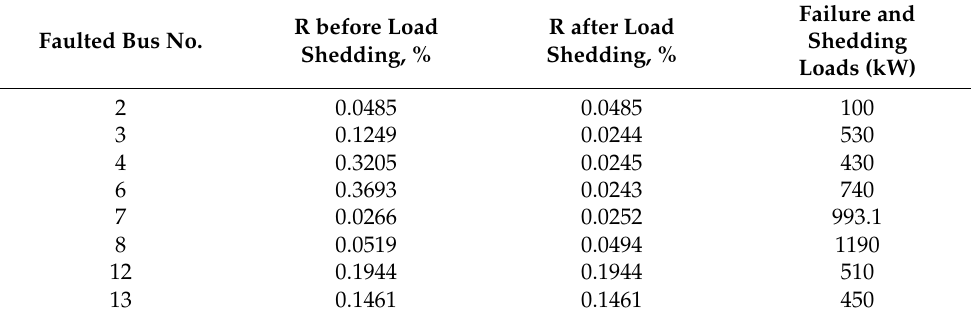
Table 7. The static security risk and load shedding